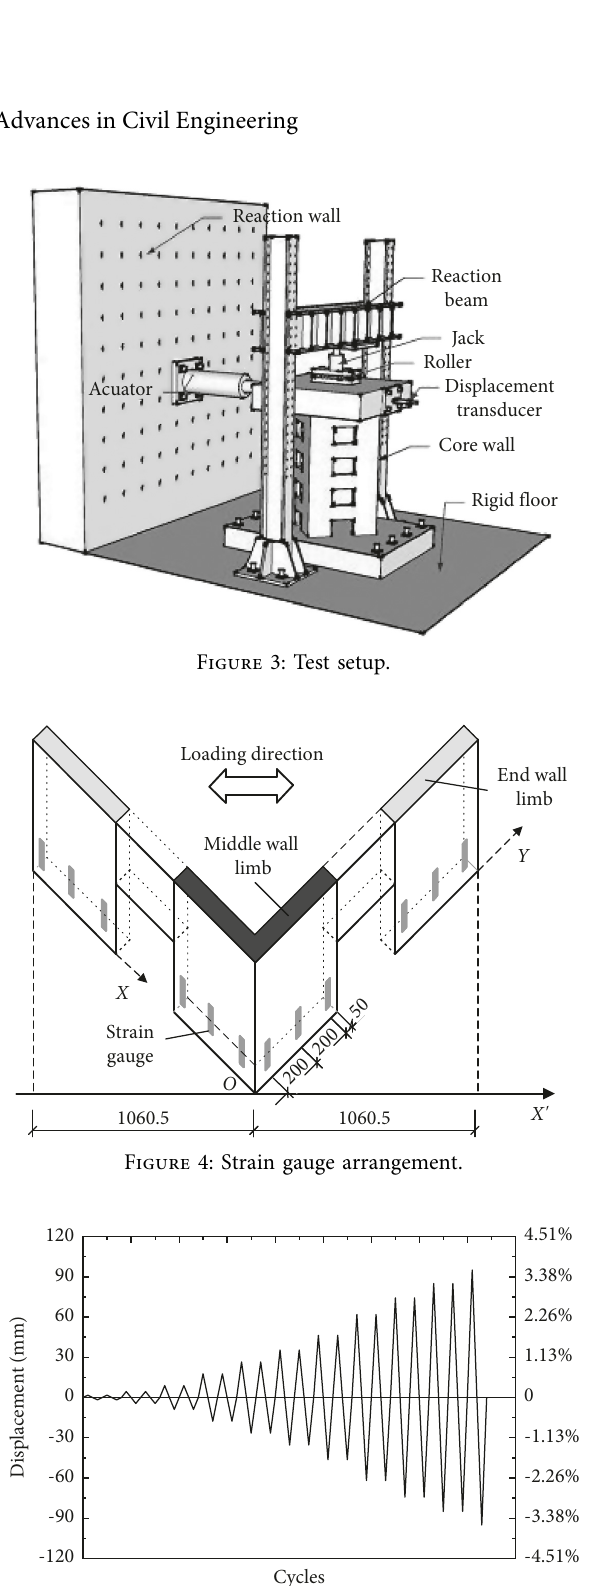
Figure 5: Loading